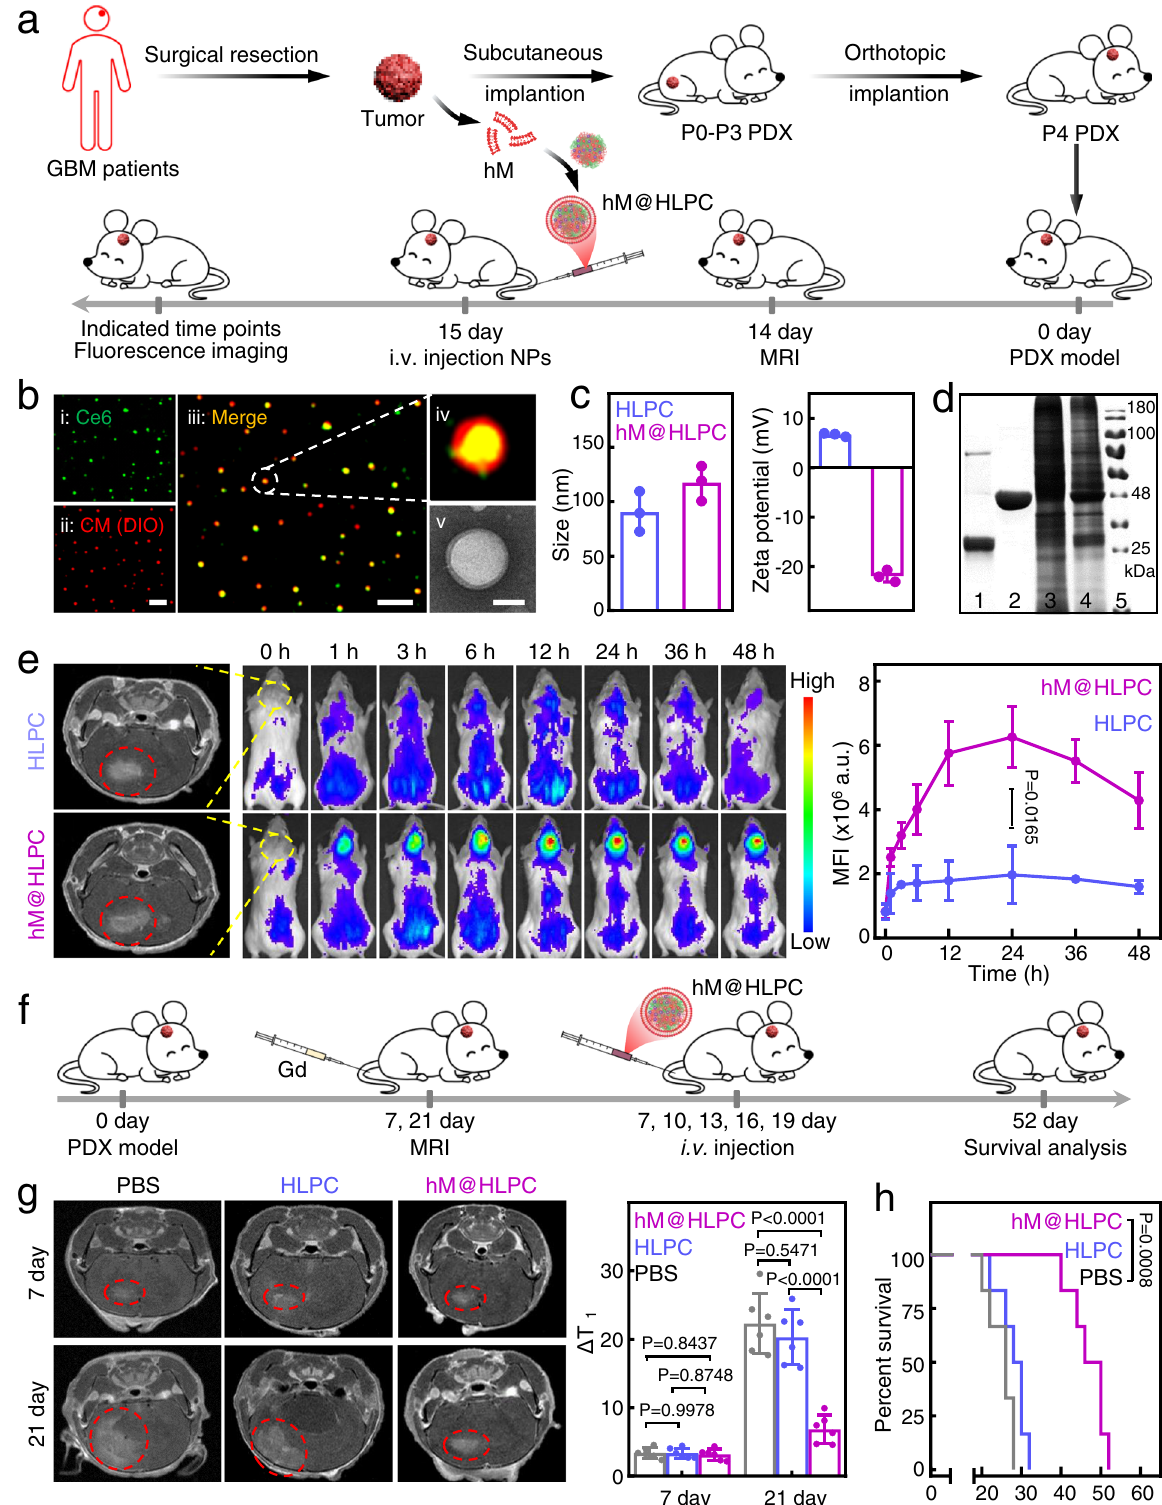
Supplementary Table 2. The siRNA sequences (Sangon Biotech, Shanghai)